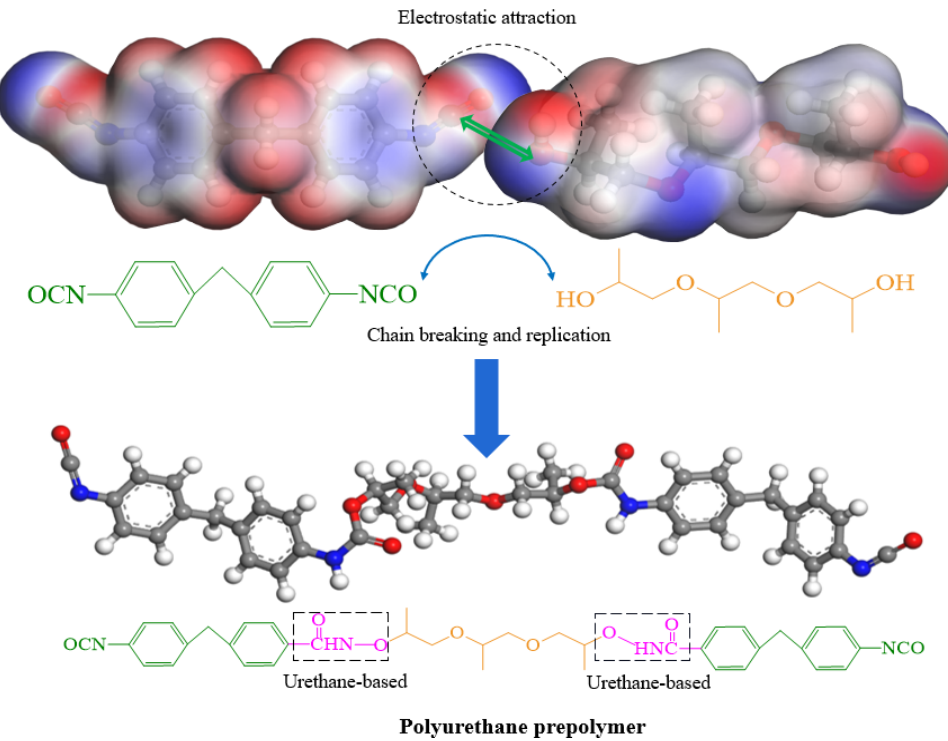
Figure 5. Polyurethane polymerization process.